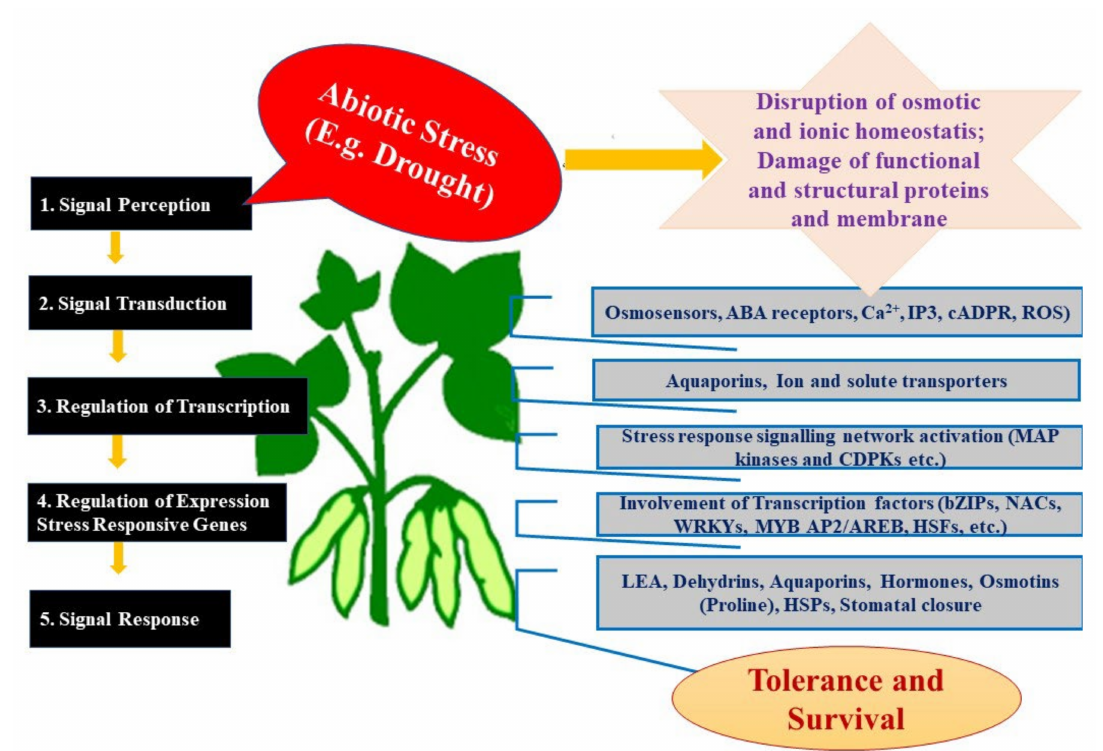
Figure 1. The response of plants to drought stress. The plant’s internal structure under drought stress is schematically described, showing the intracellular signal transduction pathways, along with the molecular regulation mechanism of plants. Drought-regulating substances, reactive oxygen species (ROS), and scavenging processes in plants are shown. An analysis of physiological and bio- chemical responses relevant to osmotic regulation metabolism, drought-induced protein metabolism, and reactive oxygen metabolism is shown (modified from Lamaoui et al. [102]; Zenda et al. [103]; Yang et al.